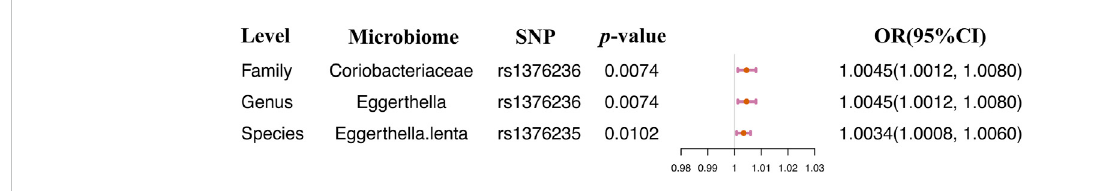
FIGURE 1 Single SNP analysis between the gut microbiome and AD. Only signi fi cant results were